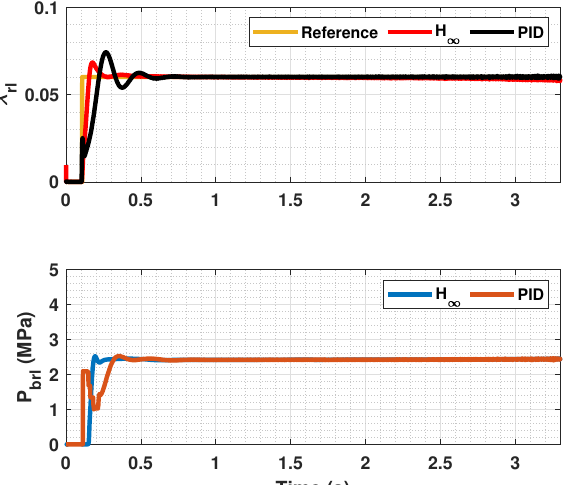
Figure 9. Rear wheels tire slip, reference tire slip and brake pressure for µ max = 0.40.